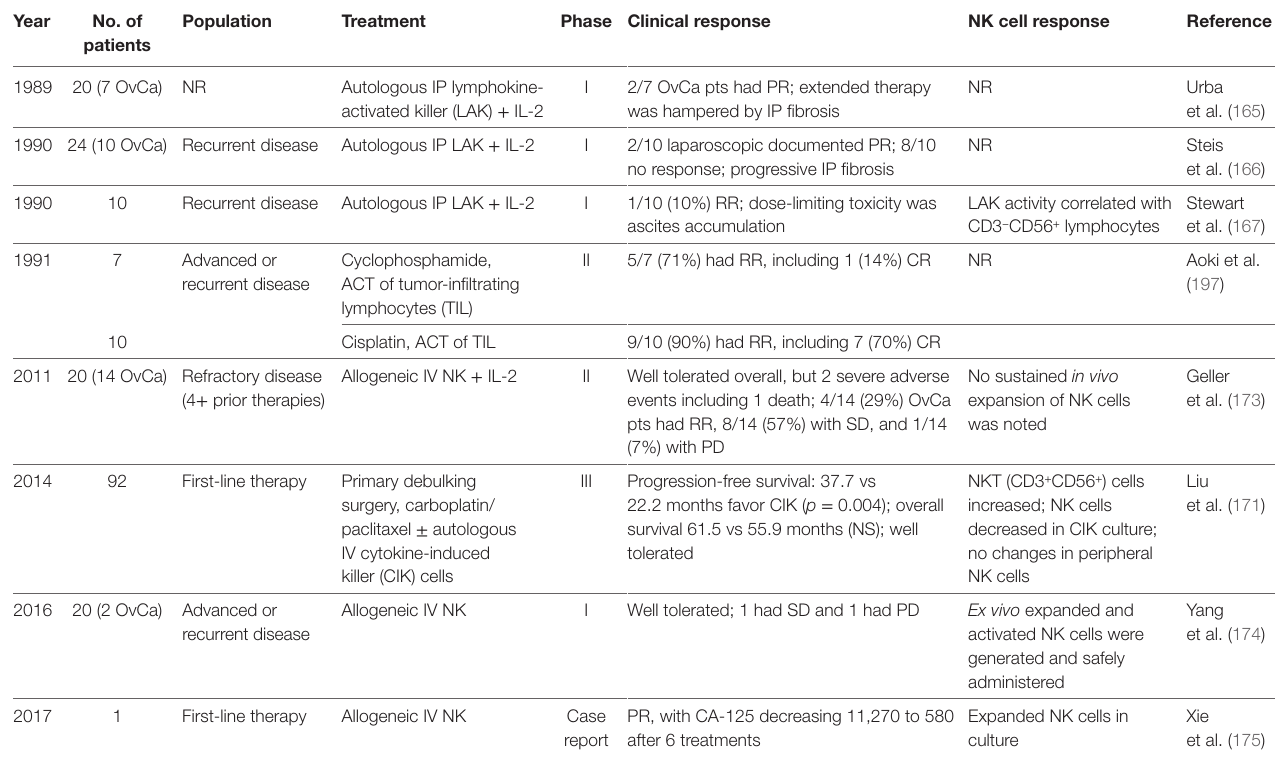
TABLe 2 | Natural killer (NK) cell findings from clinical trials of adoptive cellular transfer for ovarian